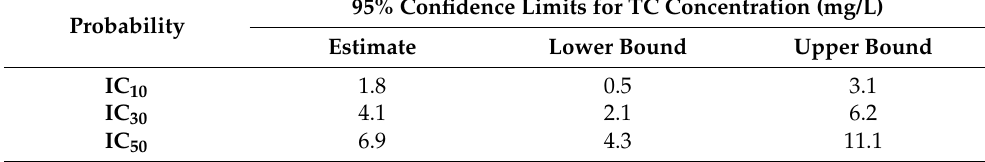
Table 1. Estimated tetracycline (TC) concentrations impacting Scenedesmus obliquus after 96 h of acute exposure.